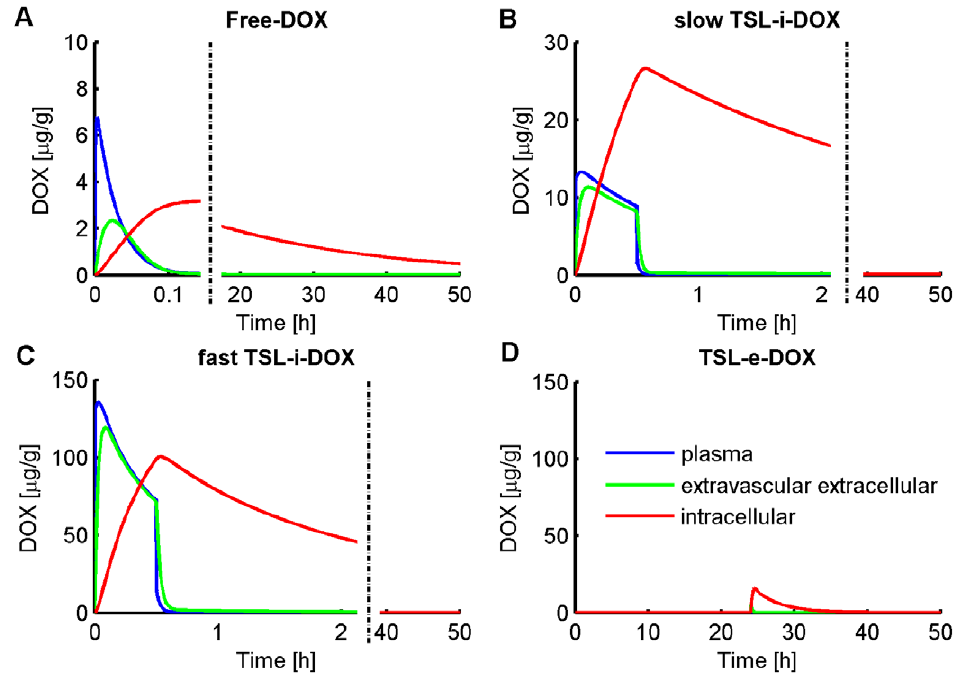
Figure 6. Plasma, EES- and intracellular tumor concentration time courses of bioavailable DOX for (A) Free-DOX , (B) slow-release TSL-i-DOX , (C) fast-release TSL-i-DOX , and (D) TSL-e-DOX . For (D), 24 h extravasation was considered with subsequent triggered release from TSL-e in interstitium and plasma. Note that EES and intracellular concentrations are relative to EES and cell volume, i.e. would need to be multiplied by appropriate volume fractions for conversion to tissue concentration.